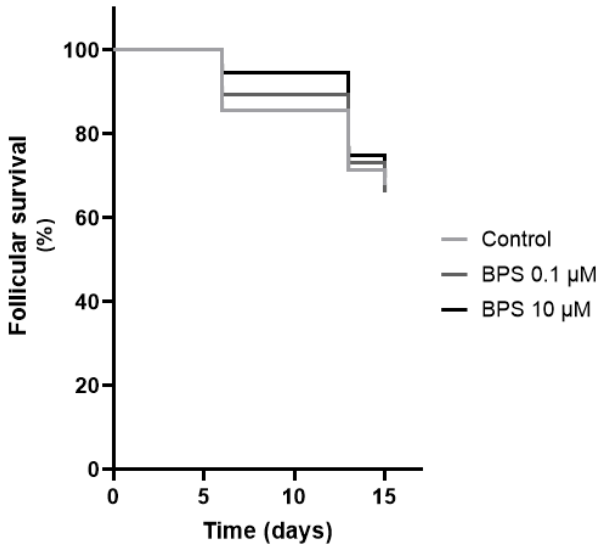
Figure 1. In vitro effects of bisphenol S (BPS) on ovine follicular survival. The survival of each follicle was assessed after 6, 13 and 15 days of treatment with or without BPS 0.1 µ M or BPS 10 µ M. A follicle oocyte. The oocyte had to be clear, and the follicular growth had to be measurable within 1 week. The results are representative of seven independent cultures with eight replicates per condition ( n = 56 per condition). The results are expressed as percentage of alive follicles and the Kaplan–Meier test. Differences were considered significant when p <